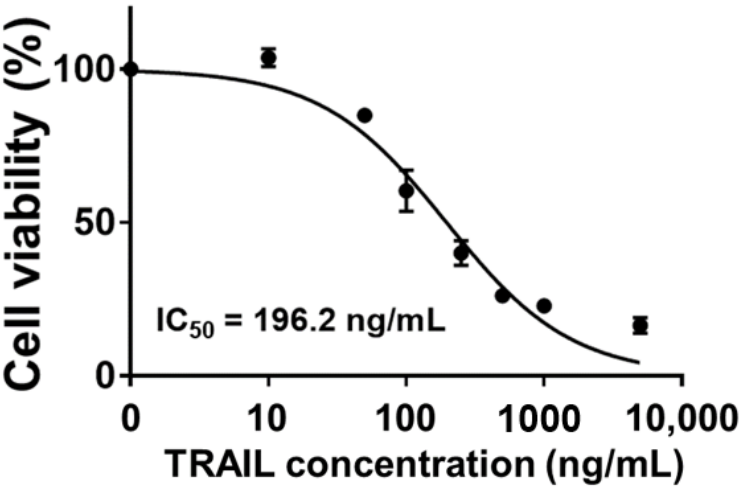
Figure 1. TRAIL-concentration-dependent cell viability of HCT-116 and determined IC 50 value.